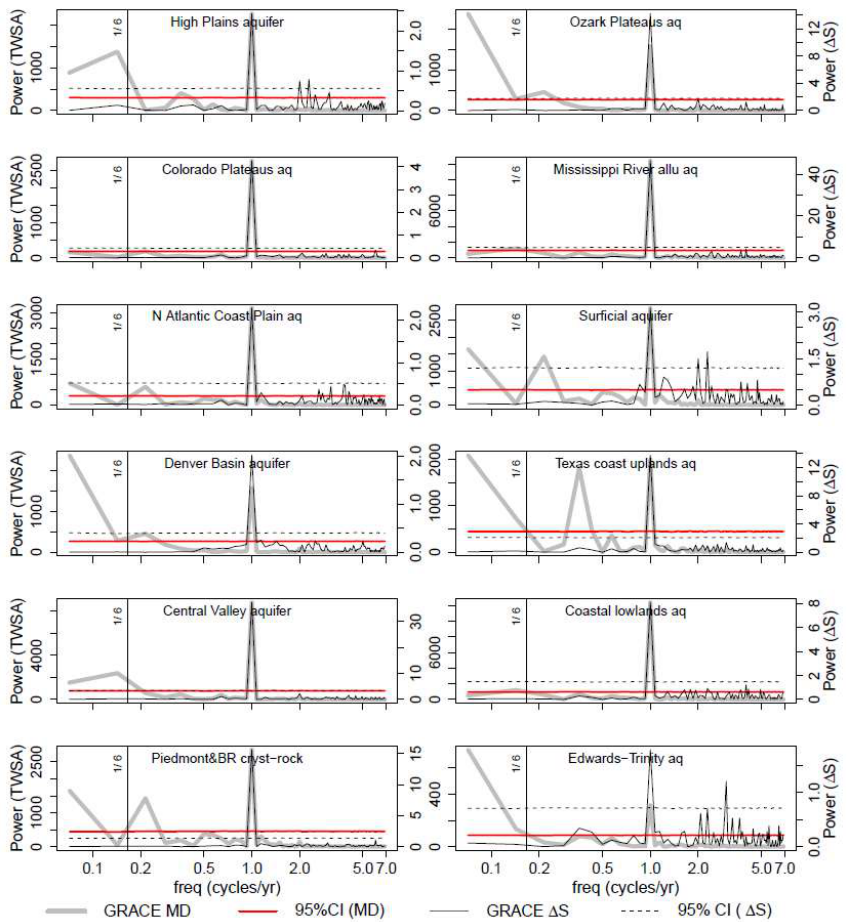
Figure 5. Scaled periodograms of basin-average spectra for GRACE TWSA (grey line) and GRACE ΔS (black line) derived for principal aquifers. The red and the dashed black lines are the 95% confidence intervals for TWSA and ΔS, respectively.